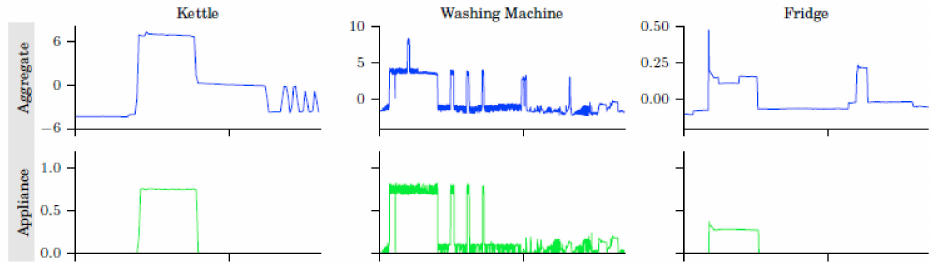
Figure 3. Similarity of stages between appliances. (Reproduced with the permission from [5],